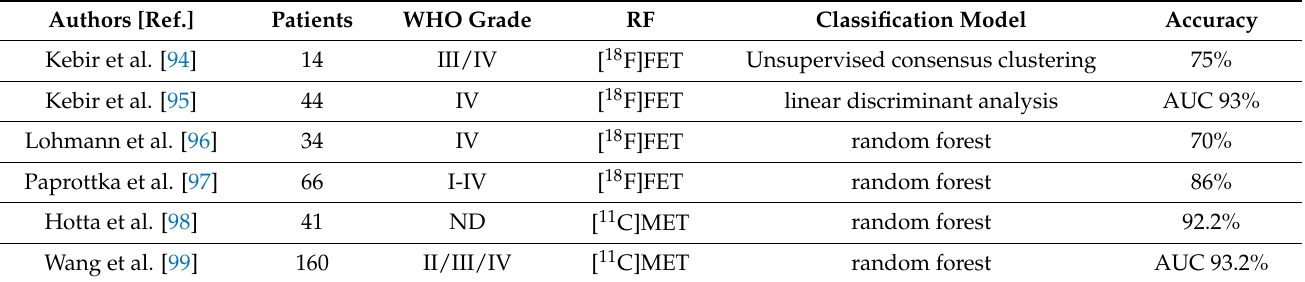
Table 4. Summary of the described studies regarding PET artificial intelligence application in glioma recurrence/differential